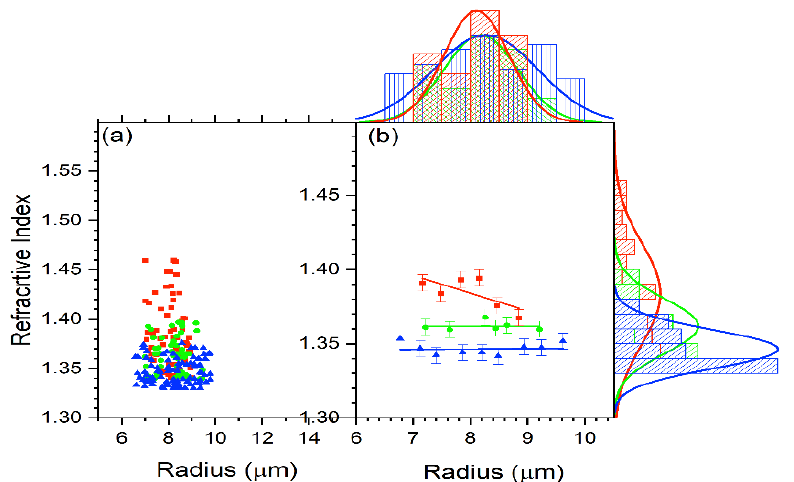
Figure 6. ( a ) The scatter plot of the charge distribution with size for control ( red), 2 h-treated (green), and 24 h-treated (blue ) group. ( b ) Reduced data for the charge vs R using Origin data manipulation reduction by grouping for control ( red), 2 h-treated (green), and 24 h-treated (blue). The charge is measured by the z number.